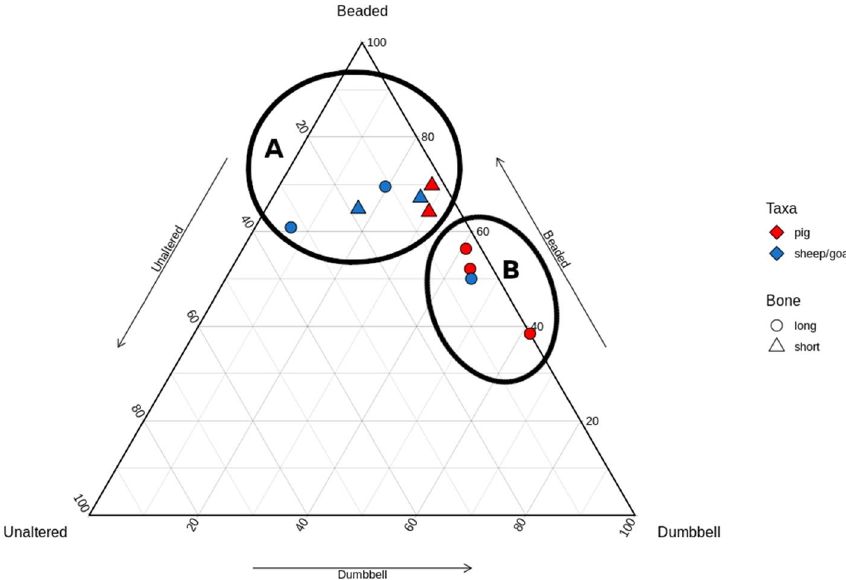
Figure 7. Ternary plot of East Chisenbury samples; two natural groups are